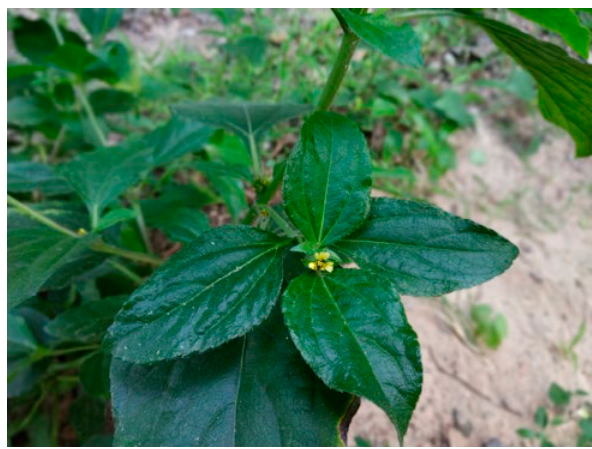
Fig. 1. Showing the aerial parts (leaf, stem, and flower) of Synedrel- la nodiflora (L.)